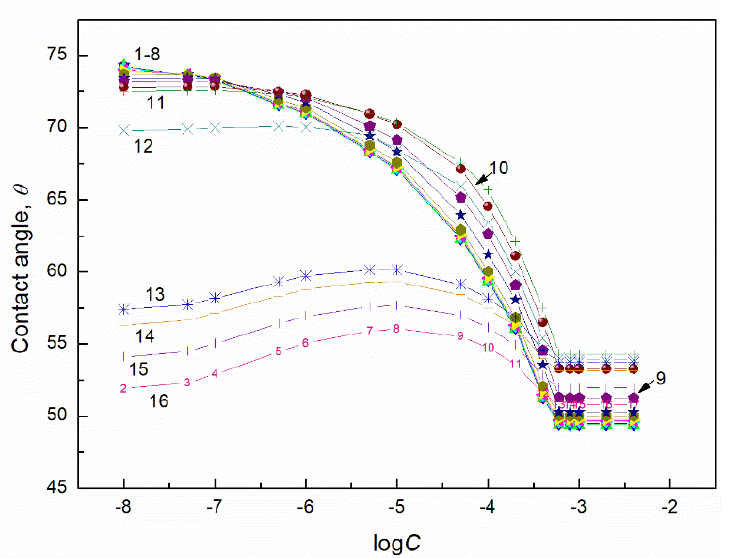
Figure 6. A plot of the contact angle ( θ ) of aqueous solution of TX165 + SF mixtures on the PMMA surface vs. the logarithm of the TX165 concentration ( C ). Curves 1–16 correspond to the constant SF concentration equal to 0.0002, 0.0005, 0.00125, 0.003, 0.00625, 0.01, 0.02, 0.05, 0.1, 0.5, 1, 5, 10, 20, 30 and 40 mg/dm 3 , respectively.